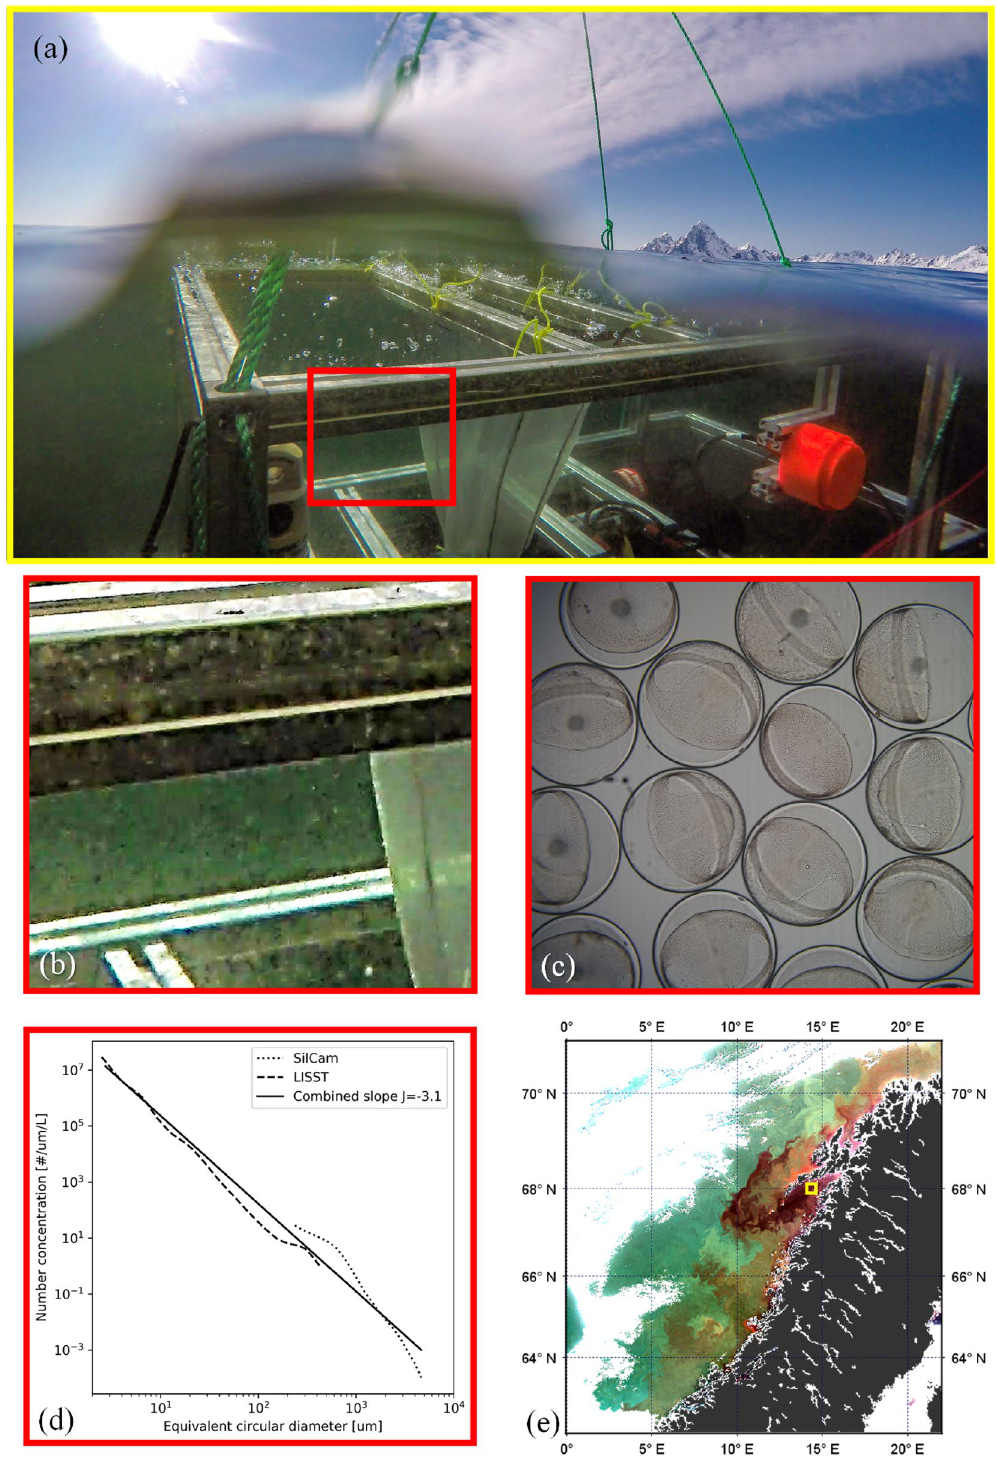
Figure 2. ( a ) A still image from a GoPro video captures a wave breaking over an instrument cage deployed off the Norwegian coast in April 2019. The image shows very high abundances of large particles, in this case primarily fish eggs and copepods, absorbing and scattering light. ( b ) Zooming in to an enhanced underwater region of the photo highlights the high abundance of large particles. ( c ) Fish eggs like these are visually coloured a light brown, preferentially absorbing blue light and are typically ~ 1.2 mm in diameter. ( d ) Analysis of images from an in situ Silhouette Camera 31 and LISST-100x 32 mounted on the frame allows enumeration of high abundances of large particles, showing the average size distribution in the upper 10 m below the sea surface. ( e ) An enhanced RGB image from the MODIS satellite from 5th April 2019 reveals strongly coloured waters in this region during the same period (data: NASA GSFC, processed by McKee using SeaDAS v7, cruise support from NEODAAS (PML) gratefully